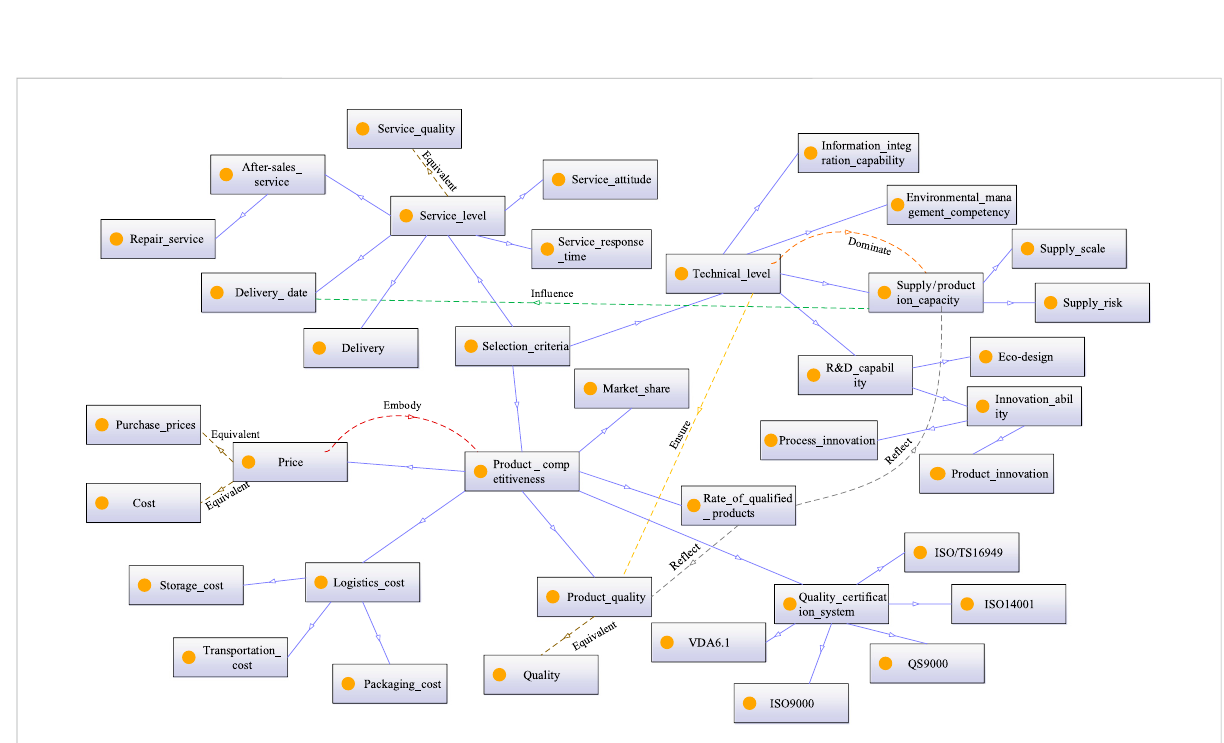
FIGURE 11 Domain ontology for NEV component supplier selection